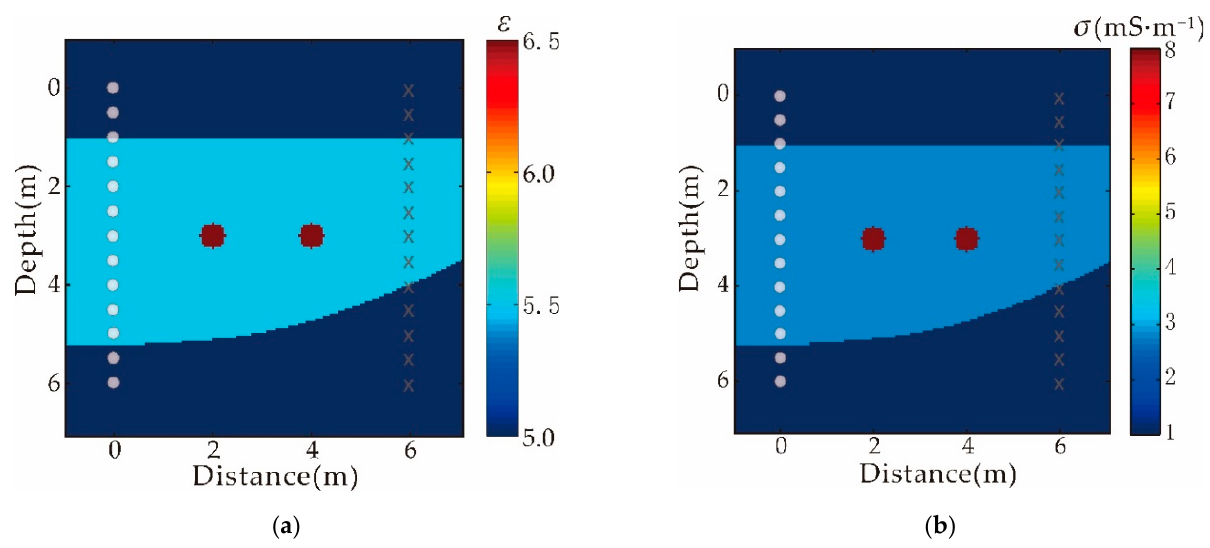
Figure 5. The original model of synthetic data, the white circle represents the transmitter and the cross represents the receiver: ( a ) relative permittivity; ( b ) conductivity.